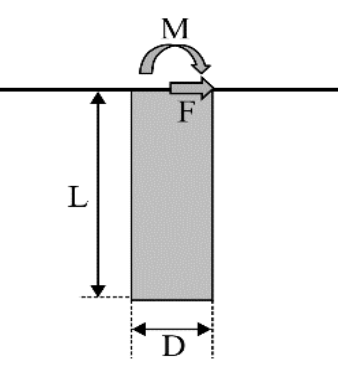
Figure 6. Laterally loaded pile in soil.